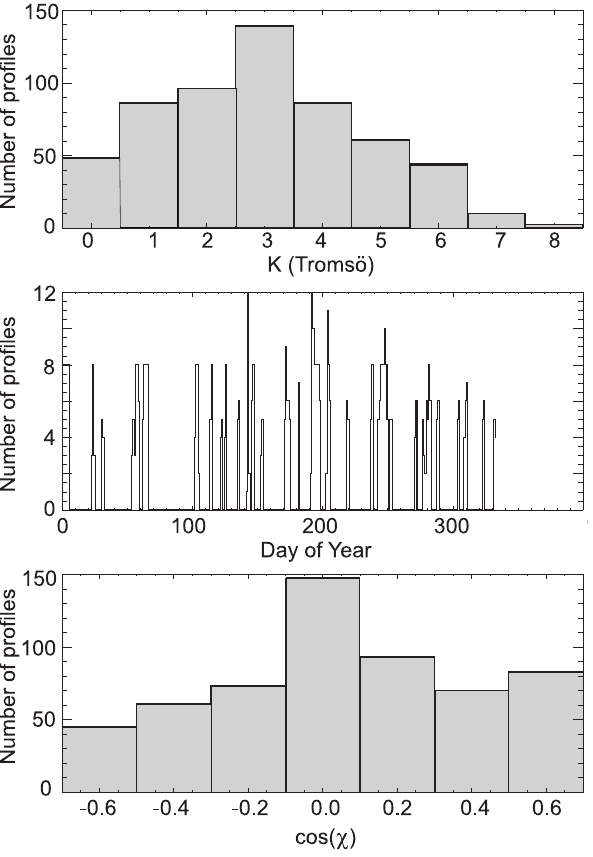
Fig. 2. Distribution of the conditions of the 572 median profile prepared for the model. Upper panel: local geomagnetic index K ; middle panel: seasonal distribution; lower panel: solar zenith angle distribution (bin size